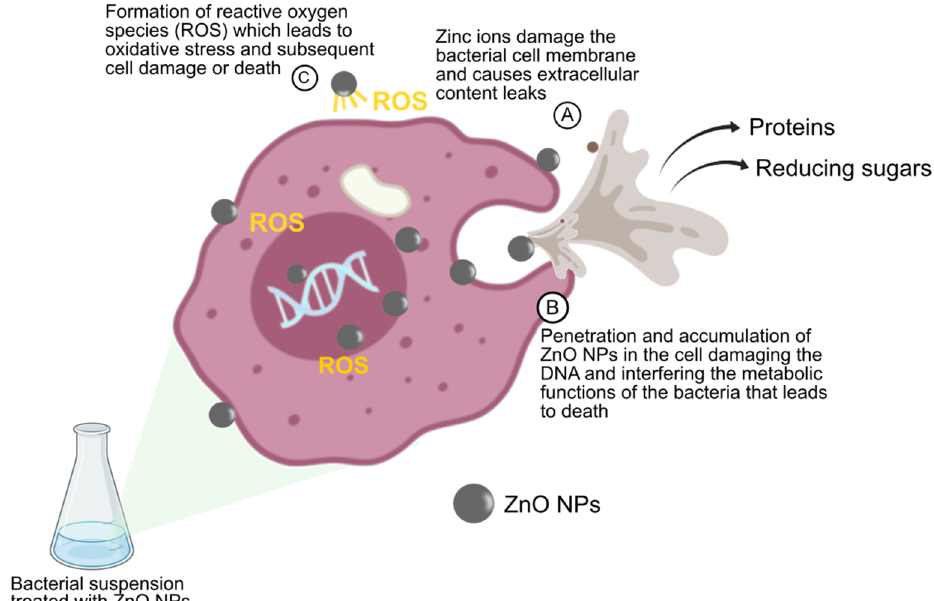
Figure 6. The proposed antibacterial actions of zinc oxide nanoparticles (ZnO NPs).